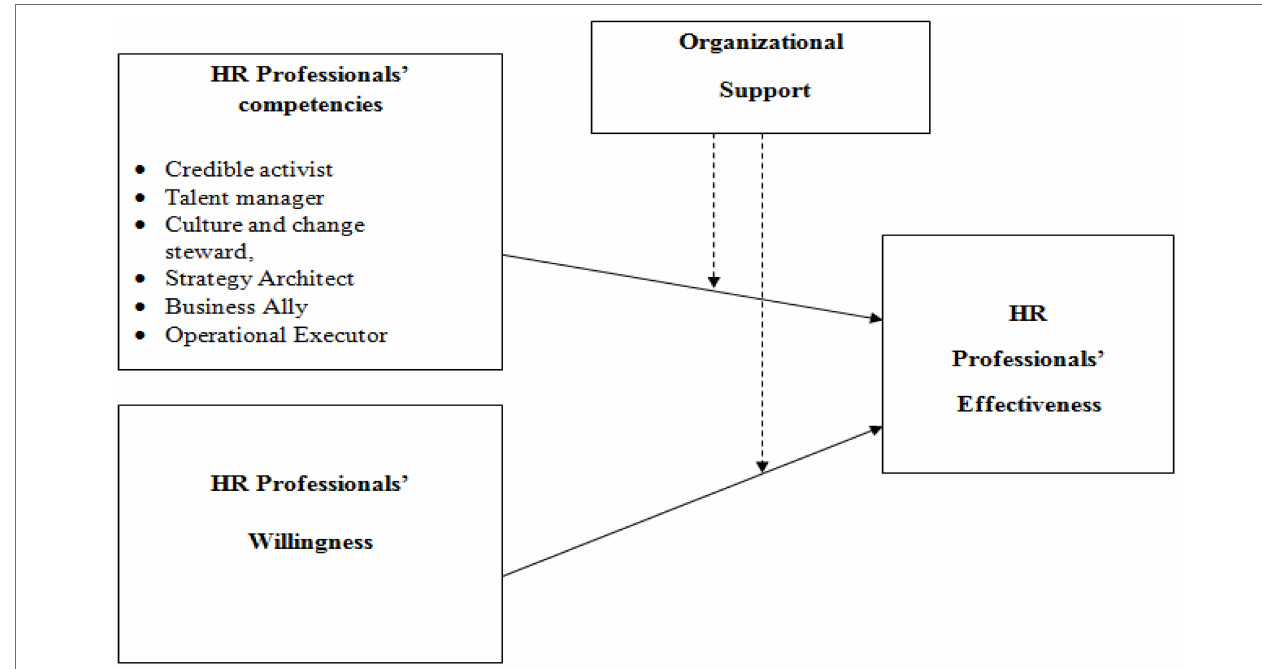
FIGURE 1 | Research